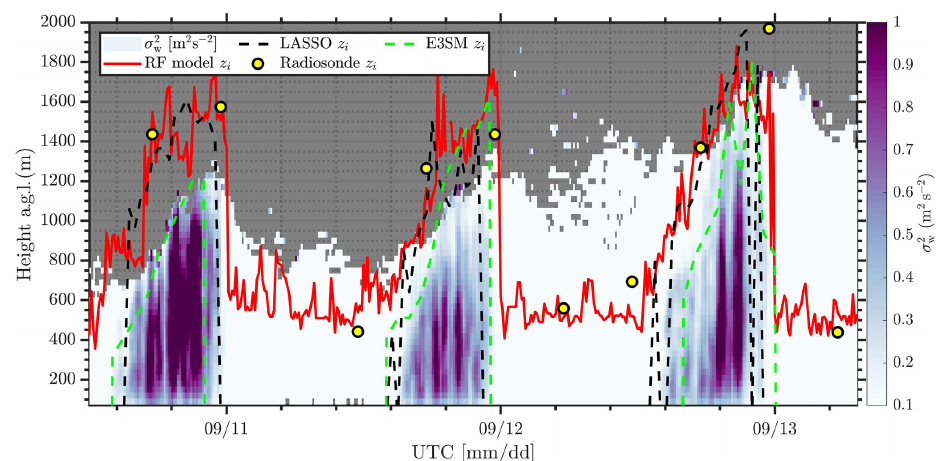
Figure 11. Vertical velocity variance ( σ 2 w ) estimates from Doppler lidar for 3d (10, 11, and 12 September 2016) with z i estimates from (a) the RF model (red solid line), (b) radiosondes (yellow circles), (c) the LASSO model (black dashed line), and (d) the E3SM model (green dashed